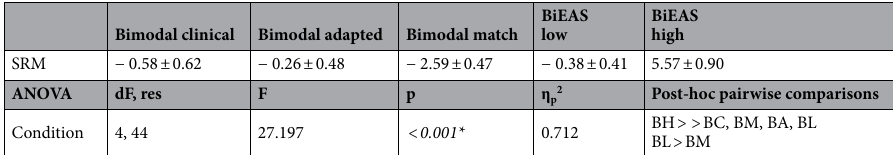
Table 2. Top: Mean SRM and standard deviation for the five listening conditions. Bottom: Results of RM ANOVA on the SRM data. Significant effects are indicated by italics and asterisks. Significant differences for Bonferroni-corrected pairwise comparisons are shown at right (> = p < 0.05; >> = p < 0.01; >>> = p < 0.001). SRM, spatial release from masking; BC, bimodal clinical; BA, bimodal adapted; BM, bimodal match; BL, BiEAS low; BH, BiEAS